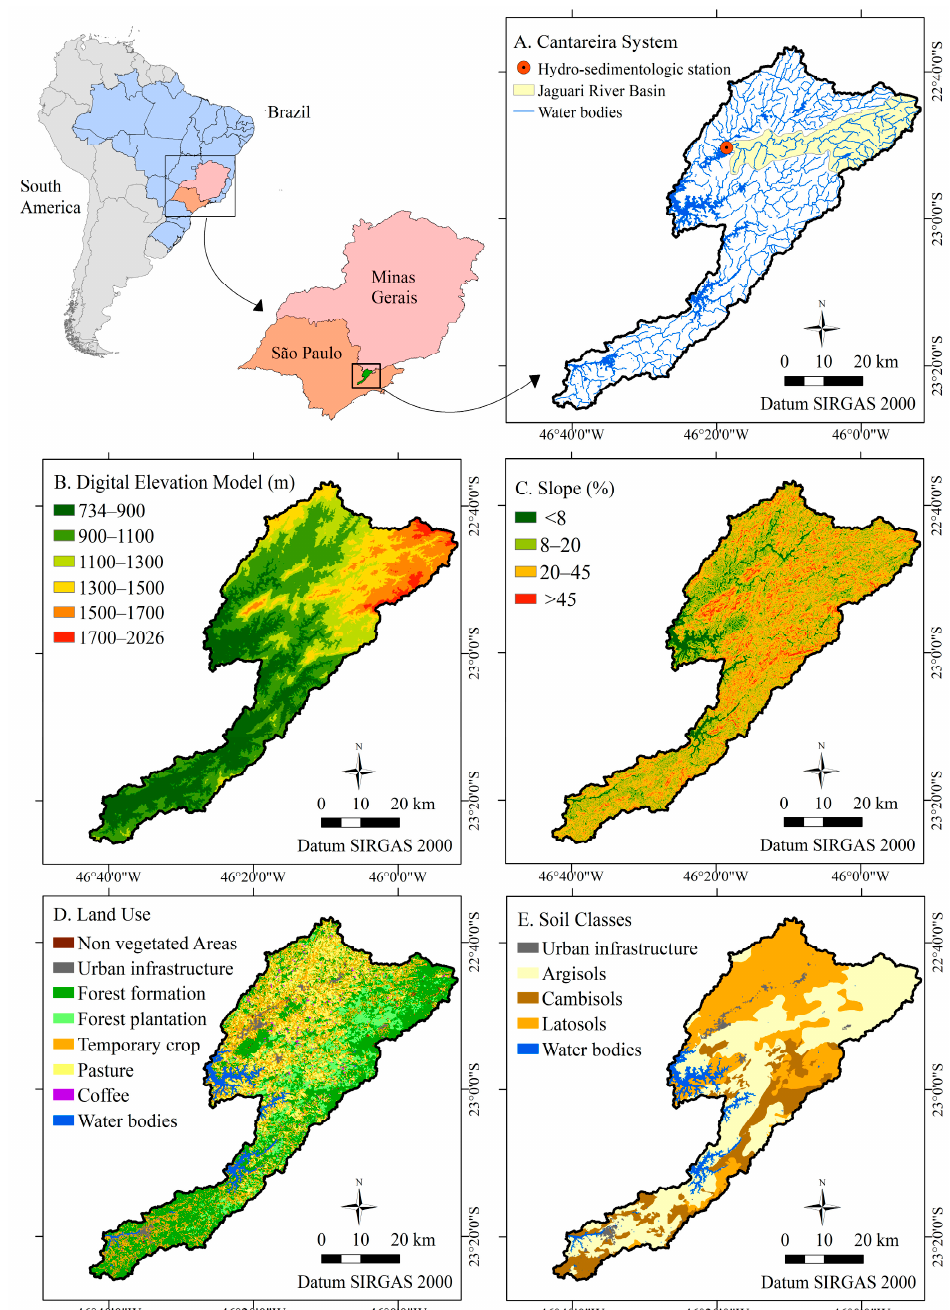
Figure 1. Study area settings. ( A ) Location of the study area; ( B ) digital elevation model (m a.s.l.); ( C ) slope map; ( D ) land use map from Mapbiomas, Collection 7 [27] and ( E ) soil class map of the Cantareira System adapted from soil maps of the states of Minas Gerais [28] and São Paulo [29]. The geographic coordinate system is UTM Sirgas 2000. The basemap is available on ArcMap v. 10.5. The Cantareira System is occupied by forest formations (45.1%), planted forest (8.46%), pastures (18.80%), temporary crops (22.47%), coffee cultivation (0.27%), water bodies (3.18%), urbanization (1.47%) and non-vegetated areas (0.25%) (Figure 1D) [27].